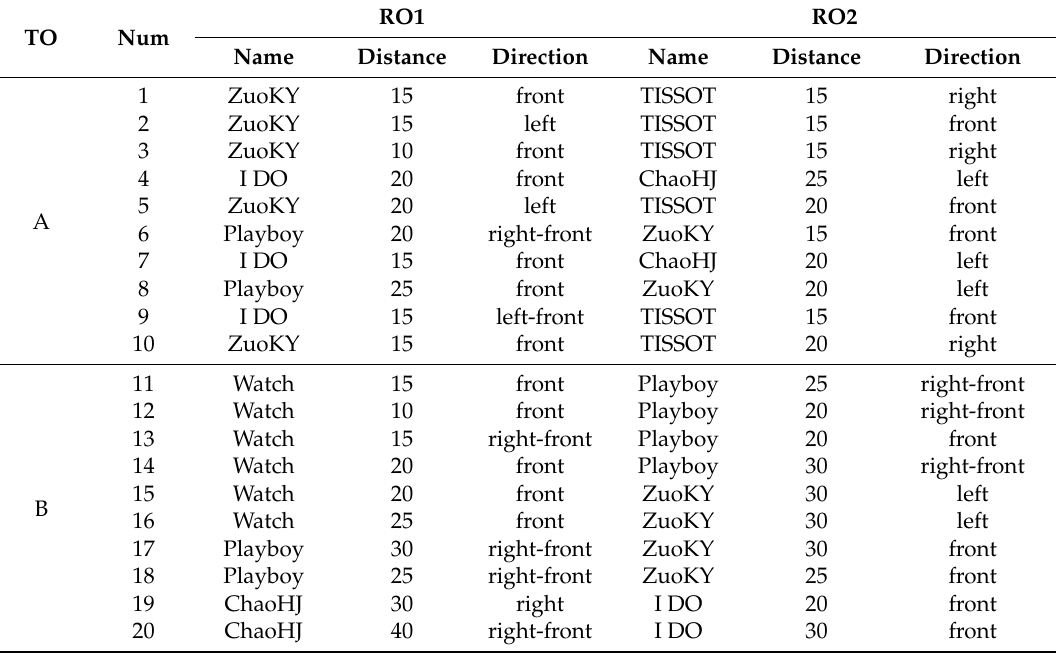
Table 1. Locality description with two ROs.